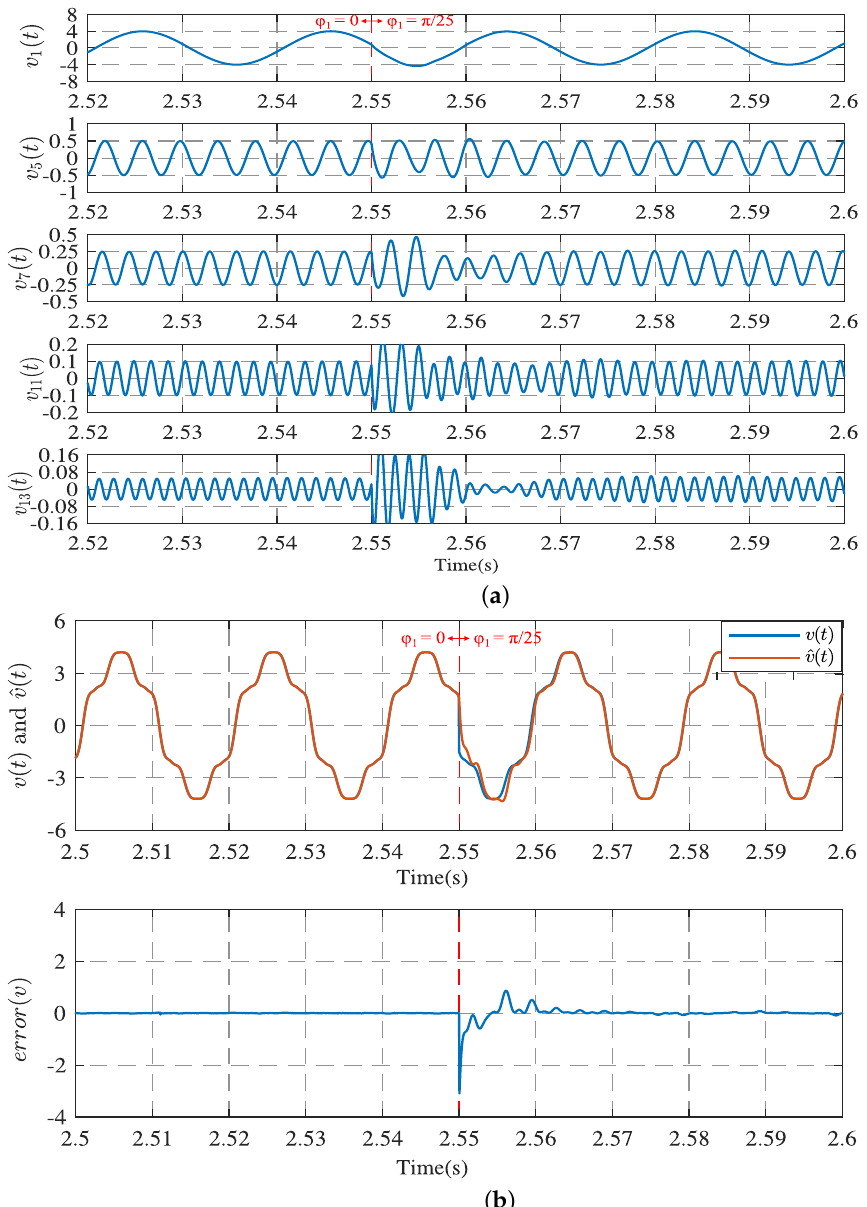
Figure 15. Experimental results: ( a ) The effect of extracting each harmonic after the phase angle jump of the fundamental of the input signal; ( b ) Comparison of the results of the observer with the real signal and the error